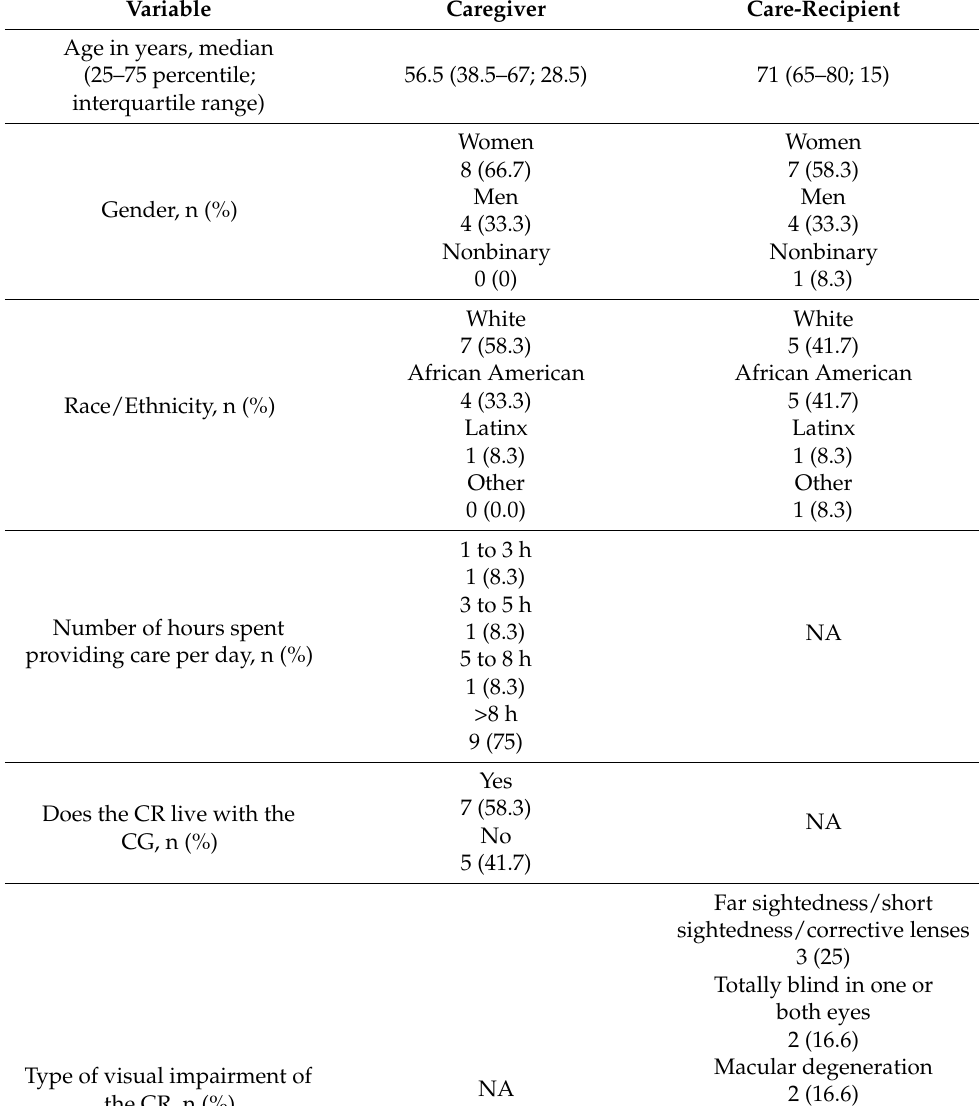
Table 1. Participant